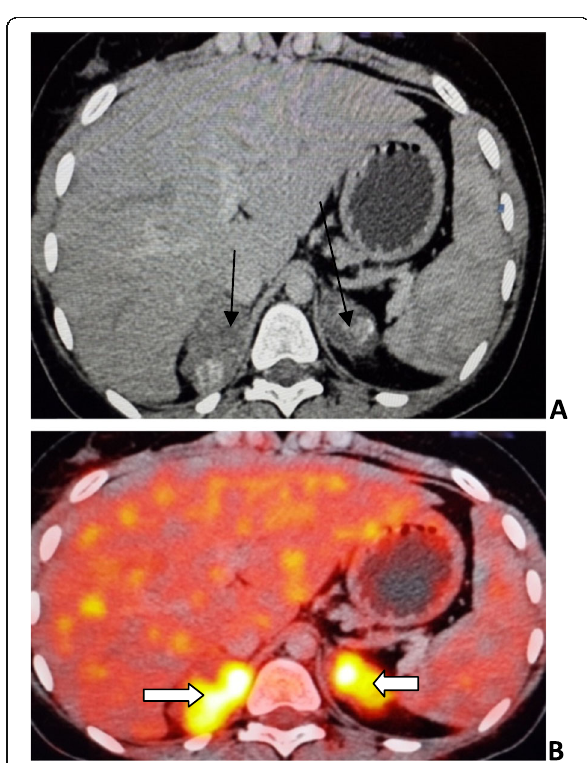
Fig. 2 A 40-year-old female patient with history of NHL presented with bilateral adrenal masses. a Contrast-enhanced CT study showing bilateral hypodense adrenal masses with areas of calcification (black arrows). b PET/CT fused image with bilateral avid FDG uptake by the visual assessment method (open white arrows)